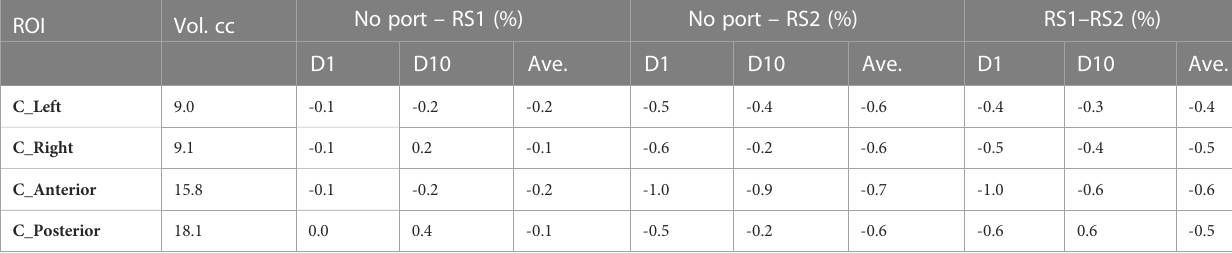
TABLE 2 Impact of TTE port in dose distributions for